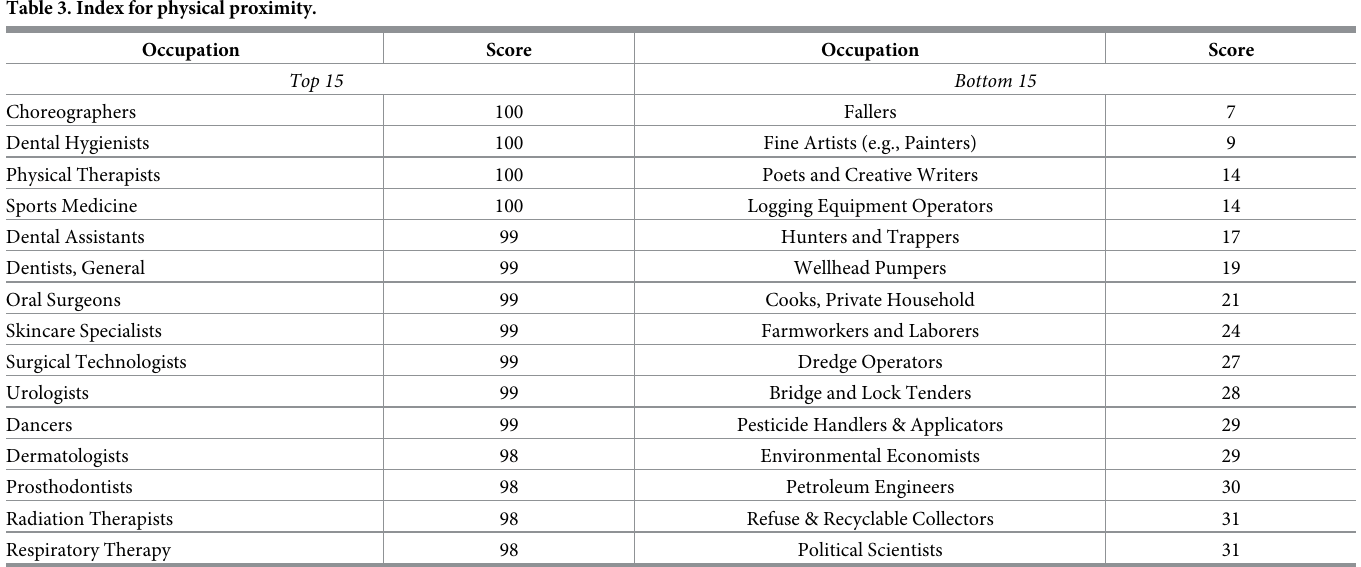
Table 3. Index for physical